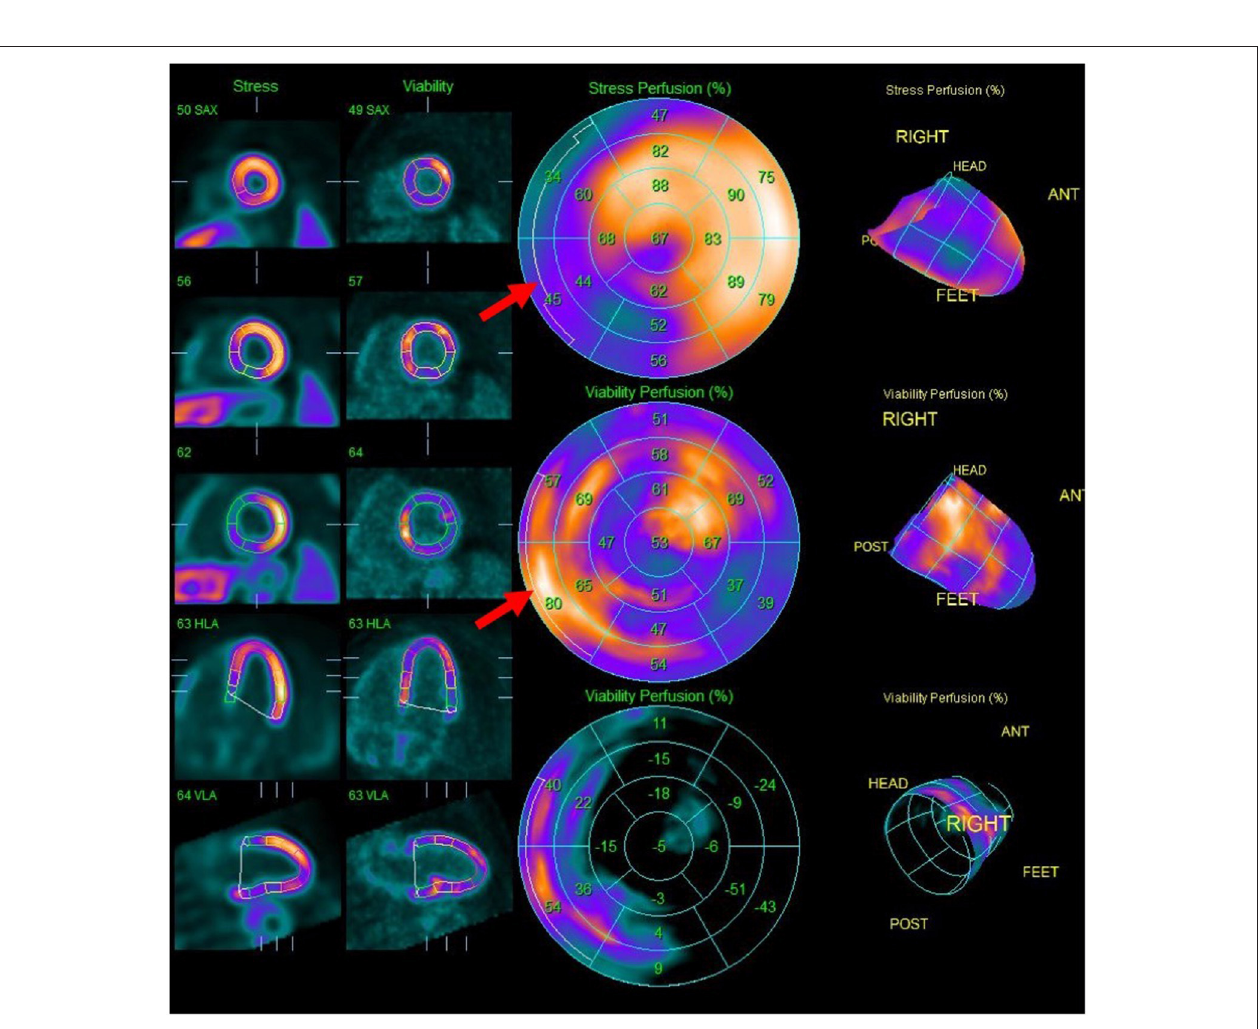
FIGURE 5 | Splash images demonstrating moderate to severe transmural perfusion abnormality mainly involving the mid-base septal and inferoseptal wall (upper row), corresponding to areas of increased FDG uptake (middle row), denoting significant inflammation causing decreased perfusion (“mismatch” pattern). Note additional sites of increased FDG uptake without corresponding decreased perfusion such as in the mid-apical anterolateral wall.